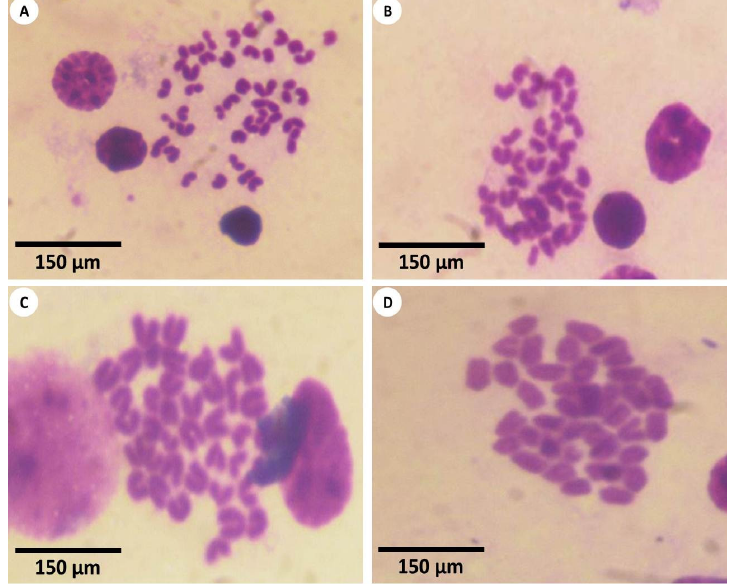
Figure 10. Metaphase smears of different bone marrow cells of mice’s femurs and humeral bones (Giemsa, 1500×) for control mice (first group) and PPE-treated mice (second group) that appeared in the following: ( A , B ) revealed control mice chromosomes of the first group with forty detectable normal chromosomes. In addition, ( C , D ) revealed normal chromosomes from mice of the second group (PPE) that are similar to the chromosomes of the first group.